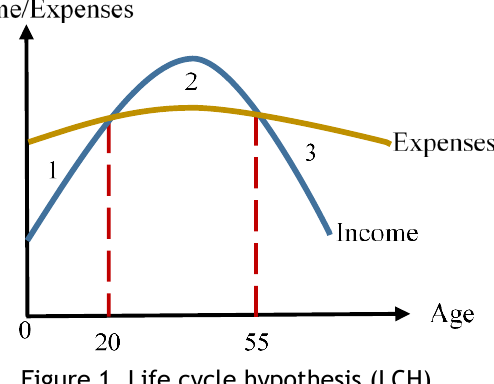
Figure 1. Life cycle hypothesis (LCH)